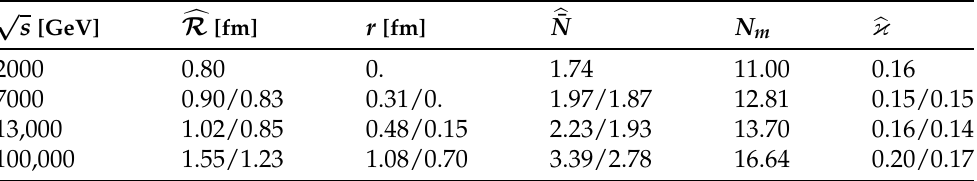
Table 2. Estimated parameters in the mode of correlated motion at is similar to that of Table